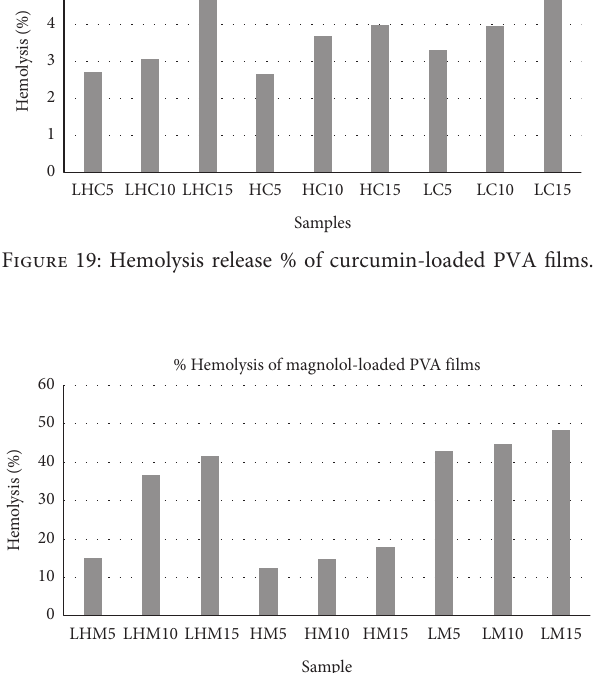
Figure 20: Hemolysis release % of magnolol-loaded PVA films.